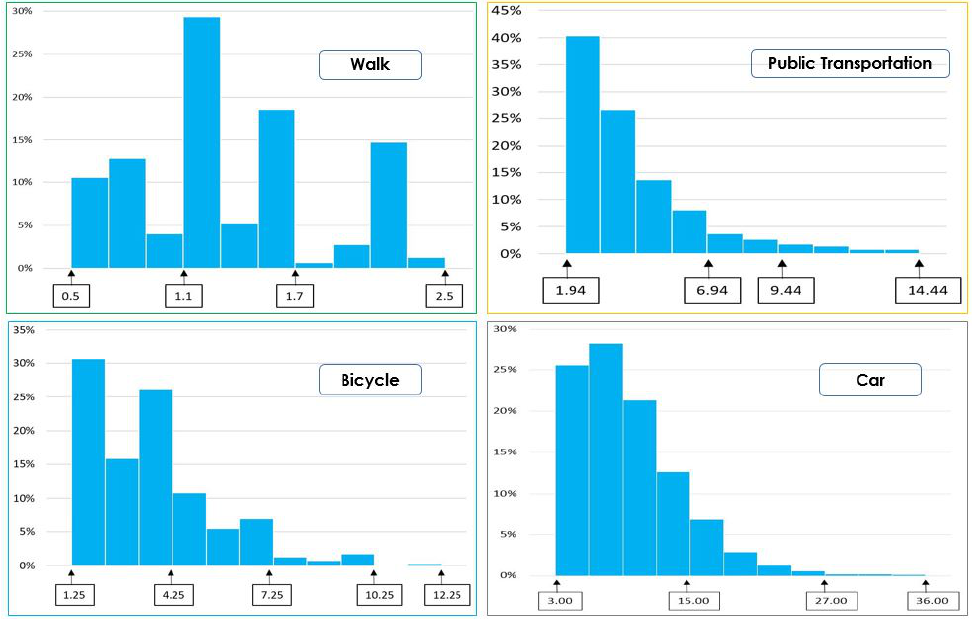
Figure 10. The travel speed distribution for the different